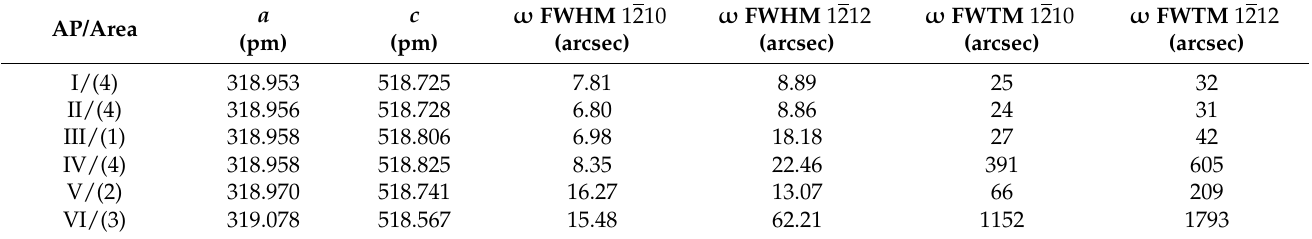
Table A1. Results of the HRXRD lattice parameters and ω -scan FWHM and FWTM measurements (cid:0) (cid:1) of the 1210 slice. Measurement positions: AP I—area (4)—center of the seed, AP II—area (4)—in the middle of the radius, AP III—area (1)—seed, AP IV—area (4)—close to the edge of the crystal, AP V—area (2) and AP VI—area